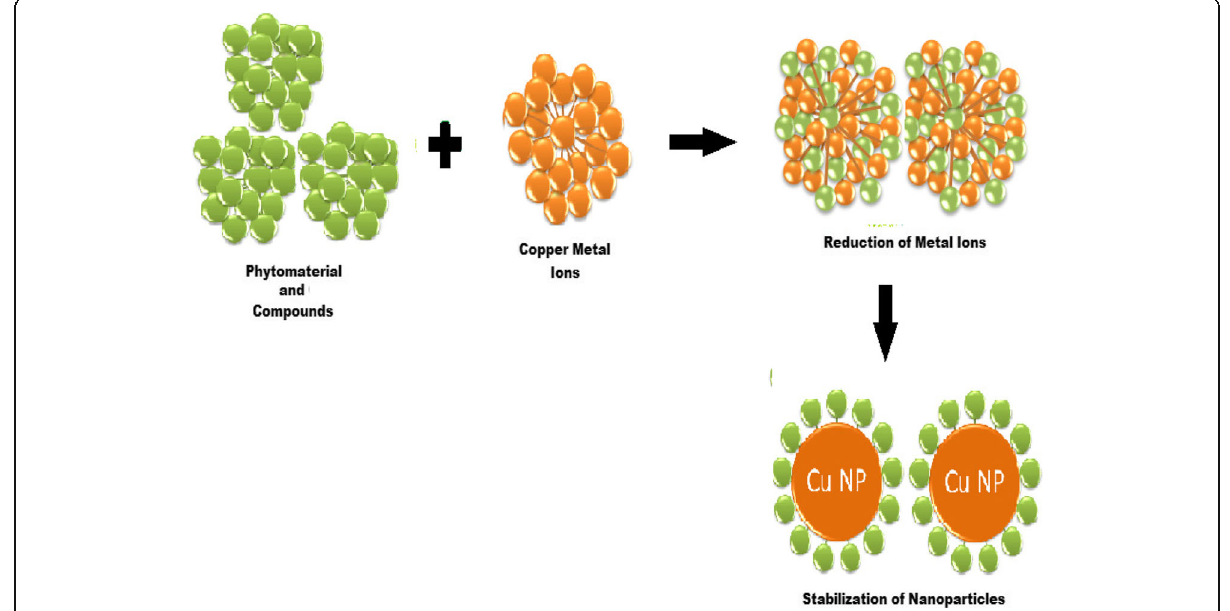
Fig. 2 A protocol for reducing the metal ions and then stabilizing the metal ’ s